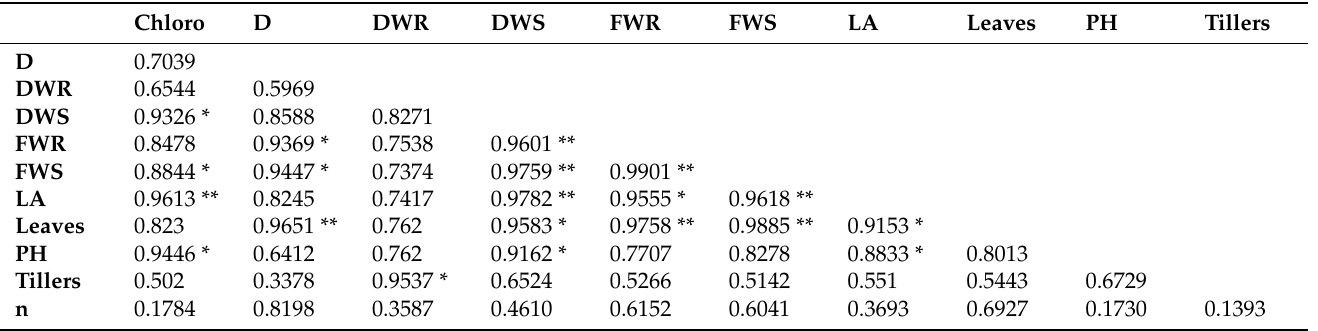
Table 4. Correlation among growth parameters and diversity characteristics of mycorrhizal